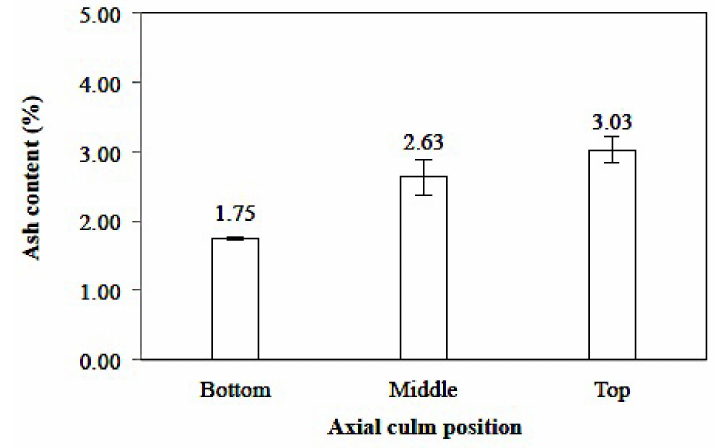
Figure 11. Ashes content based on Gigantochloa pruriens